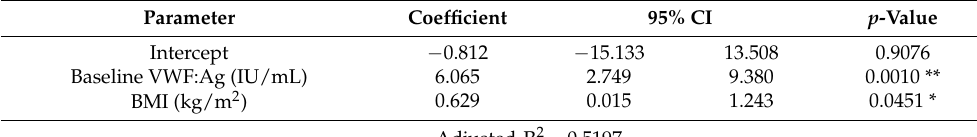
Table 6. Stepwise-backwards multivariate linear regression (MVLR) analysis of the half lives of non-O blood group patients, n = 26.